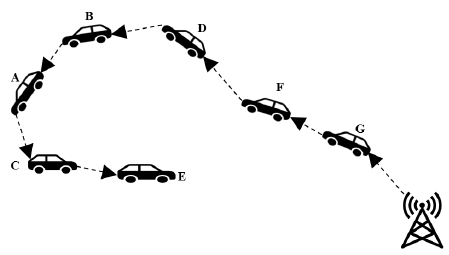
Figure 2. Downlink route-discovery process from infrastructure to